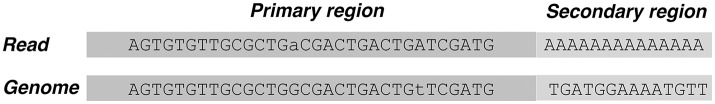
UTRme classification of read regions. Regions of each read and their counterparts in the genome are defined by UTRme as primary and secondary.